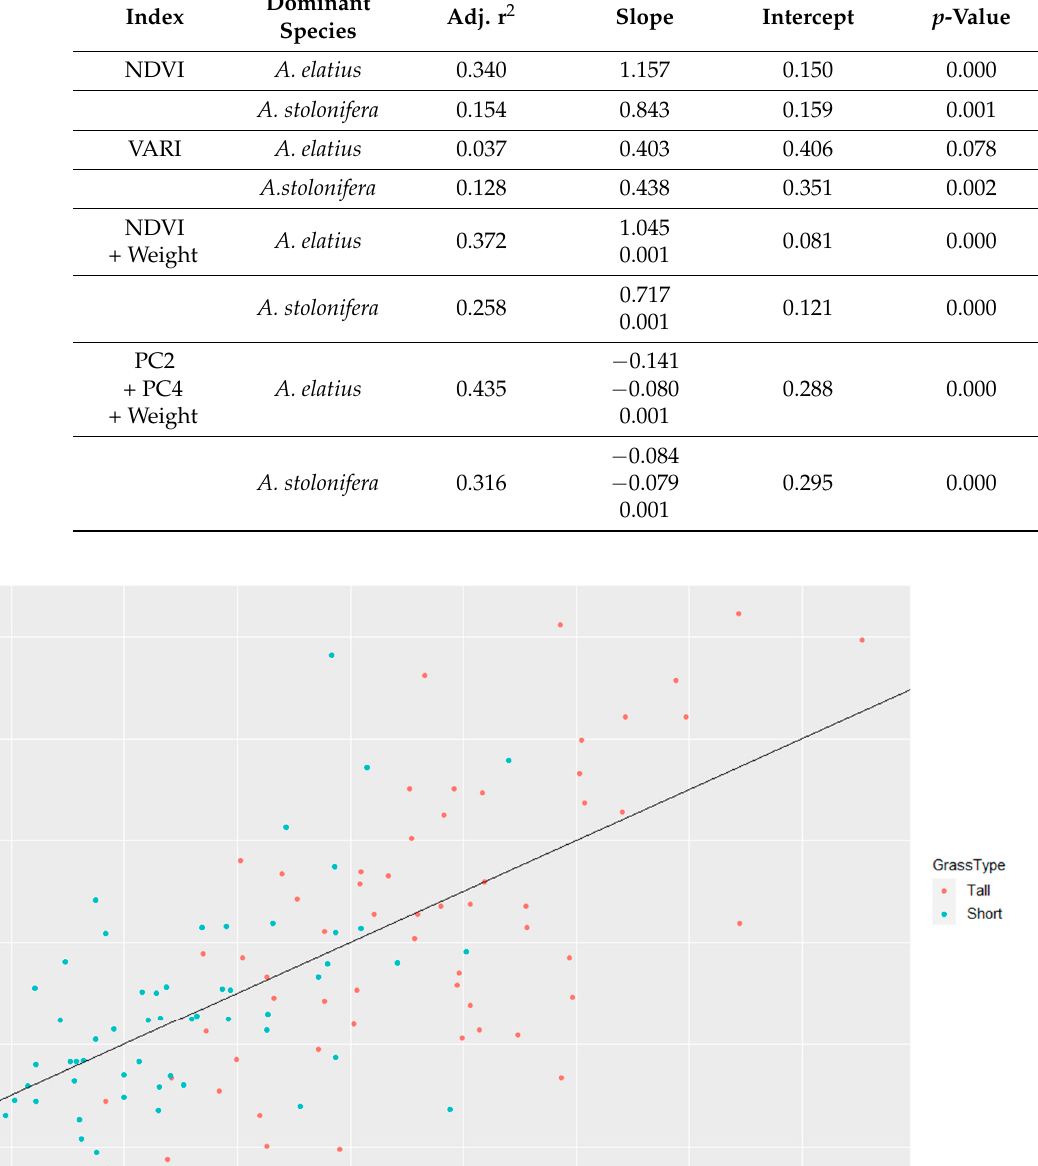
Table 5. Summary of Models for Separate Vegetation Types.